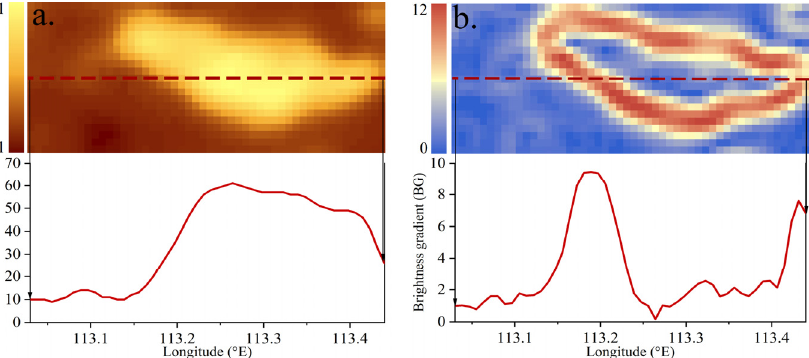
Figure 3. Comparison between nighttime lights and brightness gradients (taking Pingdingshan city of Henan Province as an example): ( a ) Nighttime lights; ( b ) brightness gradients.